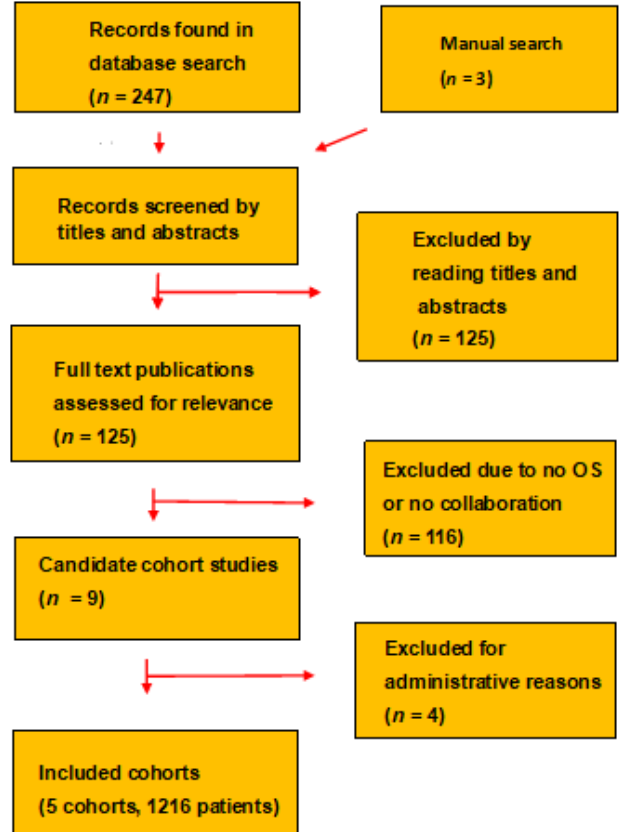
Figure 1. The PRISMA chart diagram shows how the meta-analysis selected and included the co-